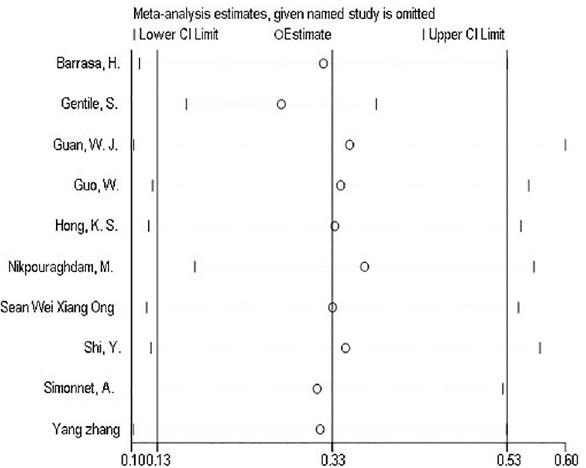
Fig 7. Forest plots of sensitivity analyses of each included study in meta-analysis of the prevalence of hypertension in Covid-19 patients.